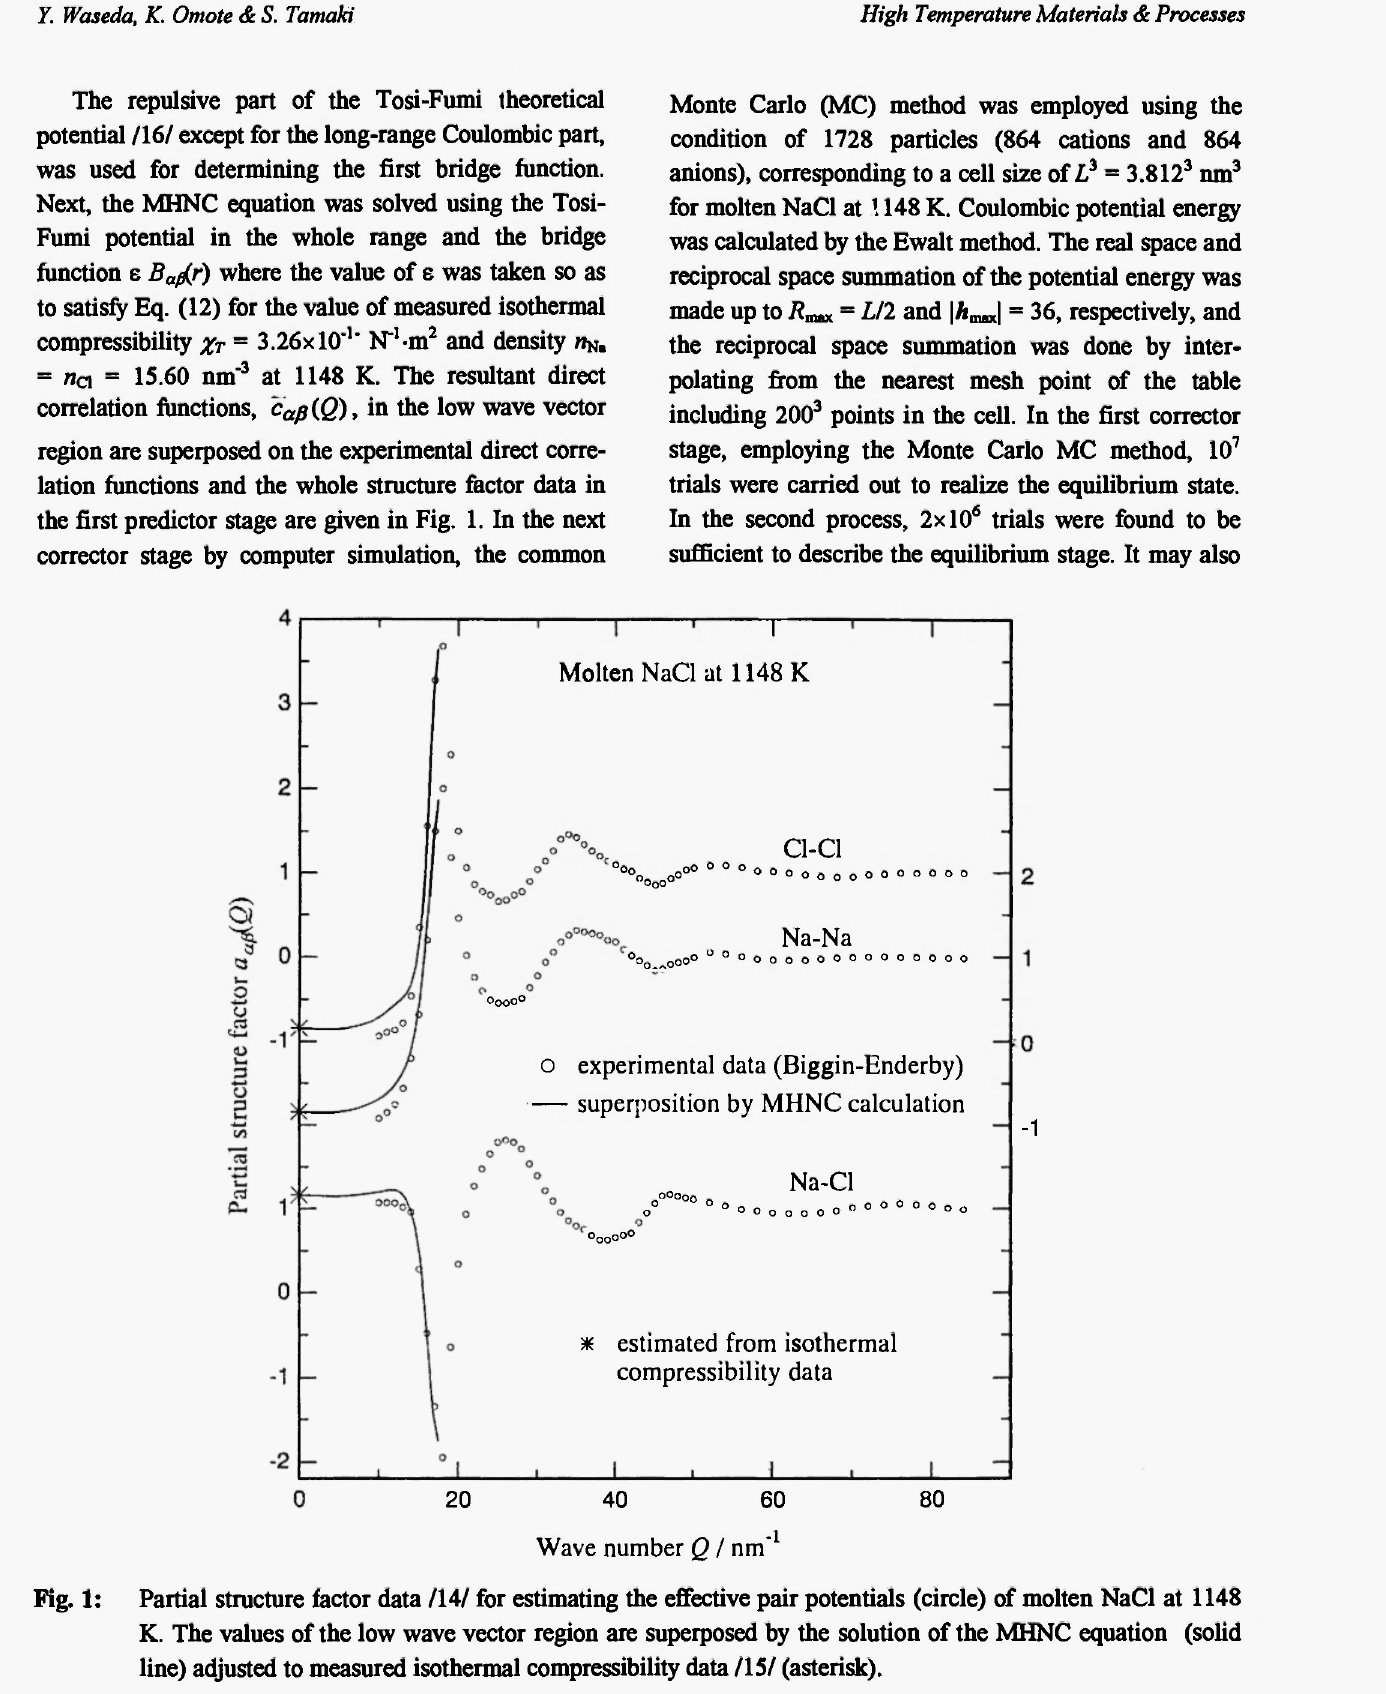
Fig. 1: Partial structure factor data /14/ for estimating the effective pair potentials (circle) of molten NaCl at 1148 K. The values of the low wave vector region are superposed by the solution of the MHNC equation (solid line) adjusted to measured isothermal compressibility data /15/